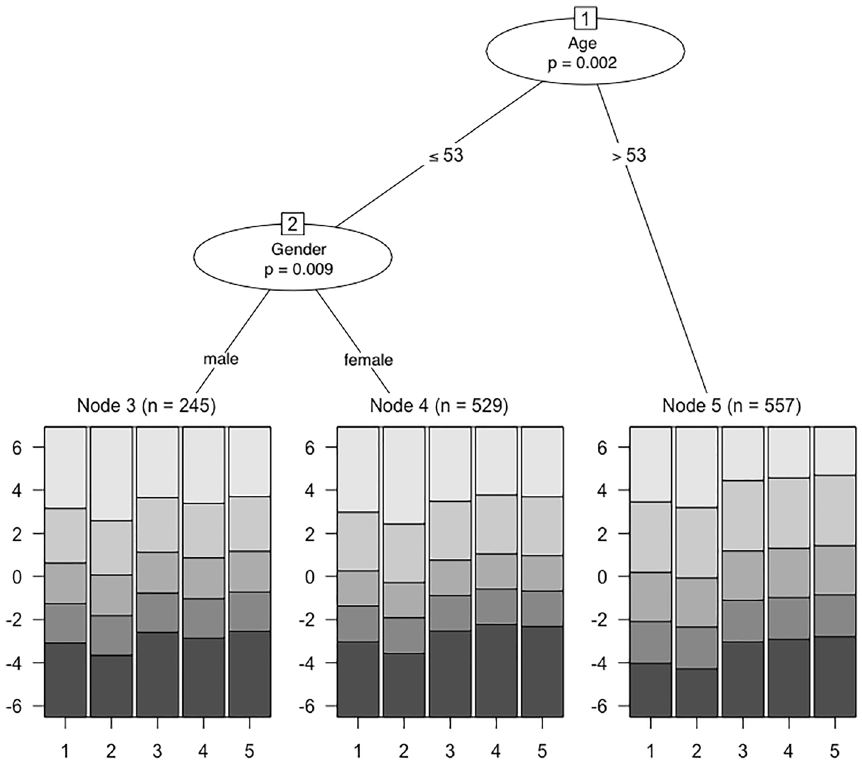
Figure 2. Rating scale tree showing differential item functioning (DIF) within the total sample. Circles symbolize variables associated with DIF. Terminal nodes correspond to subgroups for which the null hypothesis of measurement invariance was rejected. Region plots are depicted below each terminal node to show the respective item threshold